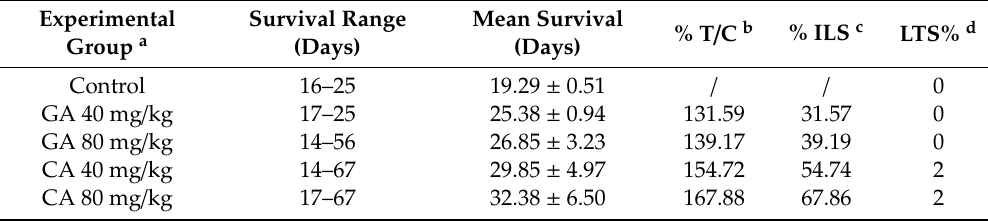
Table 2. E ff ect of GA and CA on the survival range, mean survival time, and increased life span (%) of mice bearing EAT.